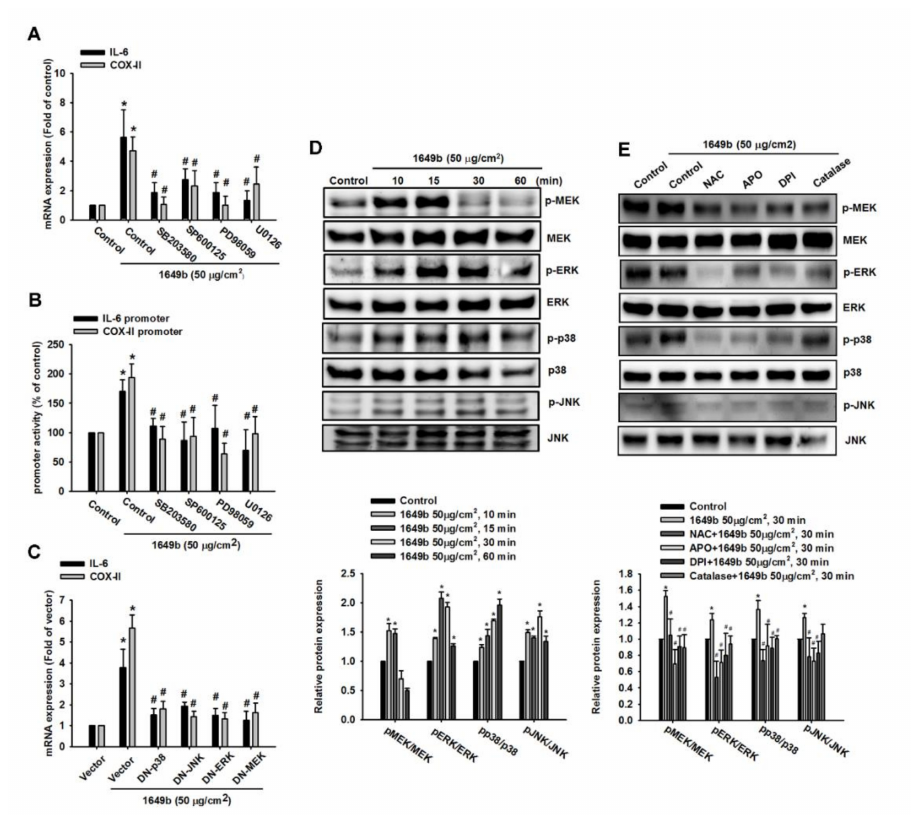
Figure 3. PMs-induced IL-6 and COX-2 expression via MAPK in human RA-FLS. ( A , B ) RA-FLS were first treated with U0126, PD98059, SB203580 and SP600125 and PMs stimulation, IL-6 and COX-II mRNA expression and luciferase activity were measured, respectively; ( C ) RA-FLS were transfected with MEK, ERK, p38 and JNK dominant negative (DN) mutants for 24 h and PMs stimulation, IL-6 and COX-2 mRNA were measured using qPCR; ( D ) At di ff erent PM stimulation durations (0, 10, 15, 30 and 60 min), MEK, ERK, p38 and JNK phosphorylated and total proteins were measured using Western immunoblotting; ( E ) RA-FLS were pretreated for 30 min with N-acetylcysteine (NAC, NADPH oxidase inhibitor), diphenyleneiodonium chloride (DPI, nonspecific flavoprotein inhibitor), catalase (ROS scavengers) and apocynin (APO, NOX-like enzymes inhibitor) followed by treatment with PMs (50 µ g / cm 2 ) for 15 min. MEK, ERK, p38 and JNK phosphorylated and total proteins were measured using Western immunoblotting. Results are expressed as mean ± SD, n = 4. * p < 0.05 compared with control; # p < 0.05 compared with the PM-treated